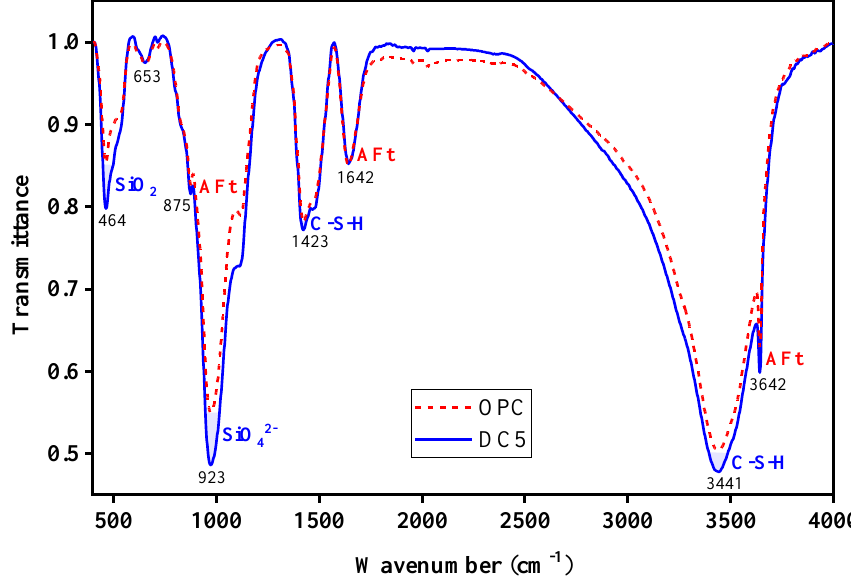
Figure 16. FTIR spectra of samples.